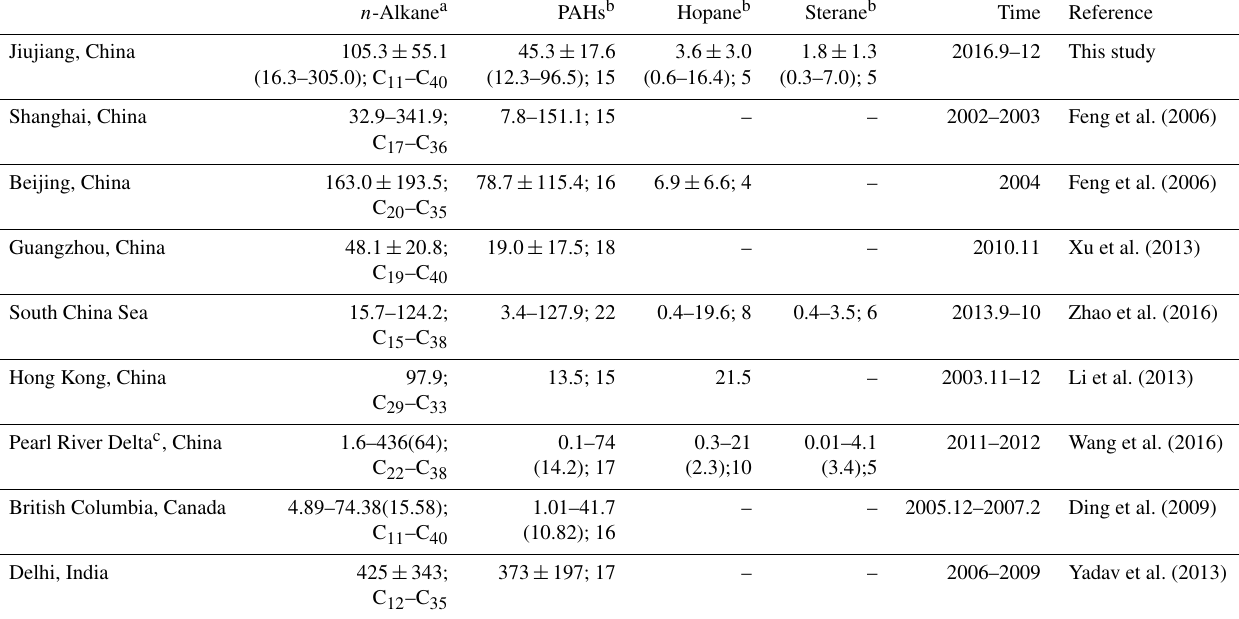
Table 2. Comparison of NPOC concentrations between Jiujiang and other areas (ngm − 3 )